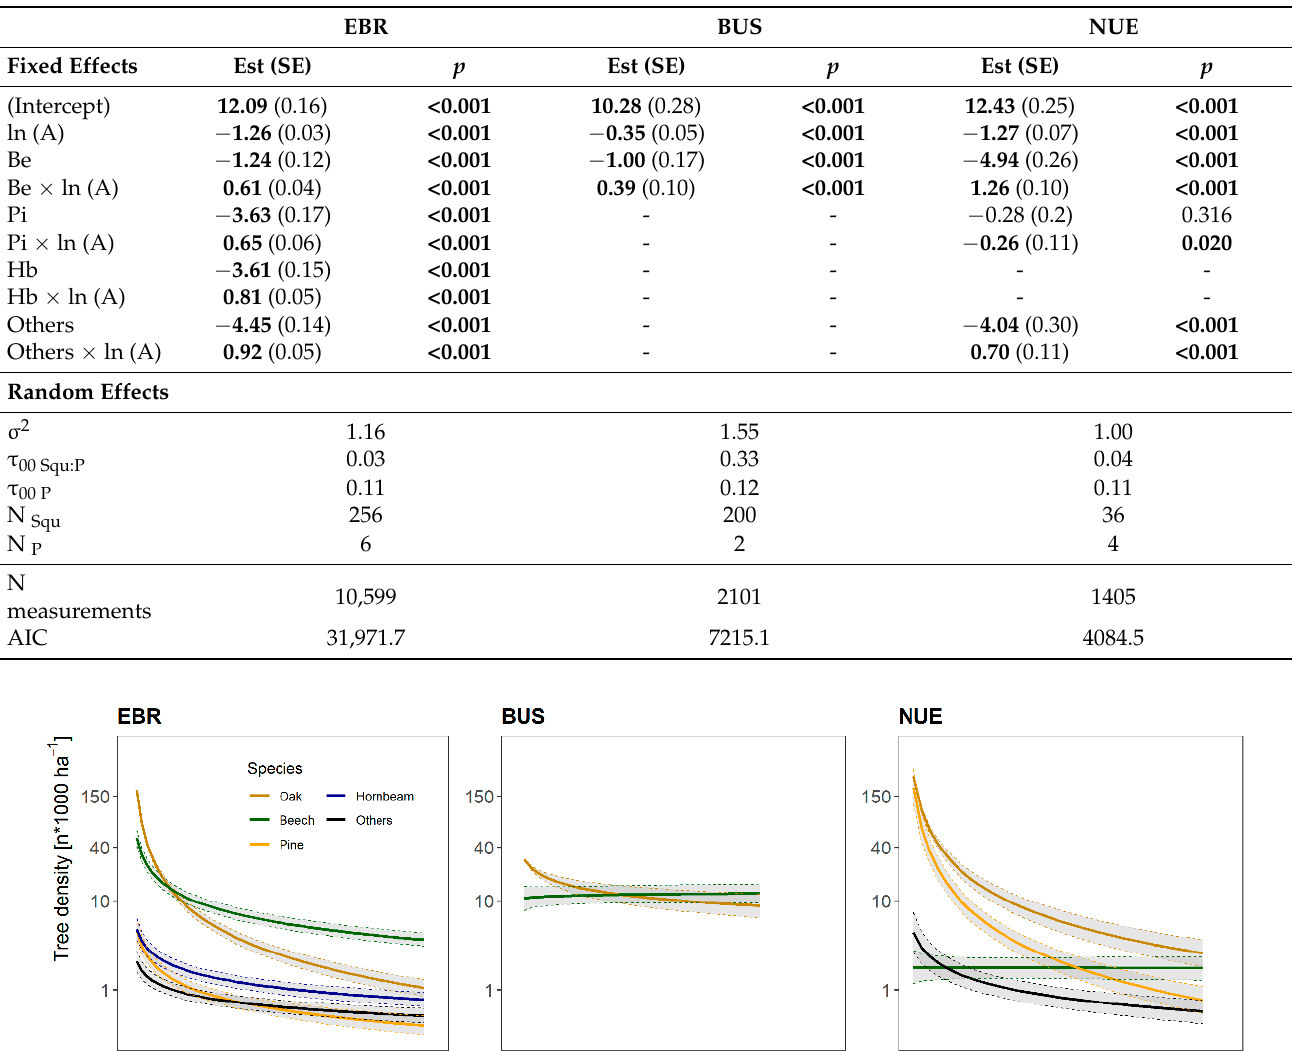
Table 4. Model statistics for tree density as a function of regeneration age (A) (Equation (3)); the reference tree species is oak; Est—estimated value; SE—standard error; p — p -value; significant values are written in bold.